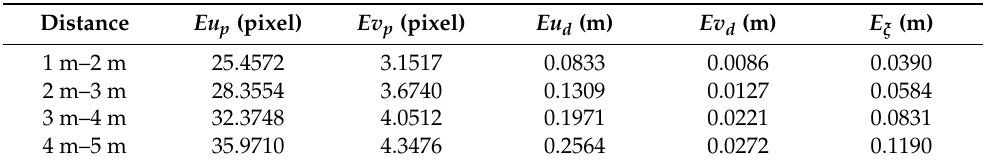
Table 2. Remapping error